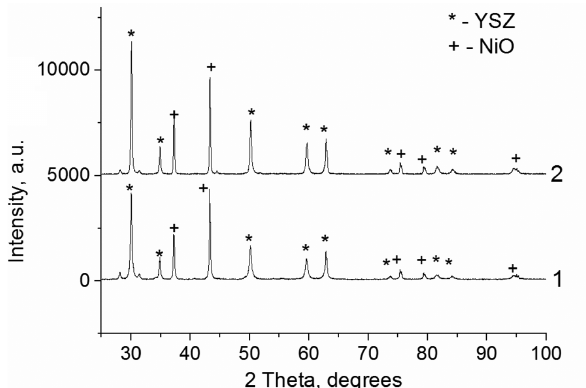
Figure 2: The NiO-YSZ layers surface (a, c) and cross-section (b, d) after sintering at a tem- perature of 1,250° С in an argon atmosphere (a, b) and a temperature of 1,200° С in vacuum at a residual pressure of 1.33·10 – 3 Pa (c, d) for 2